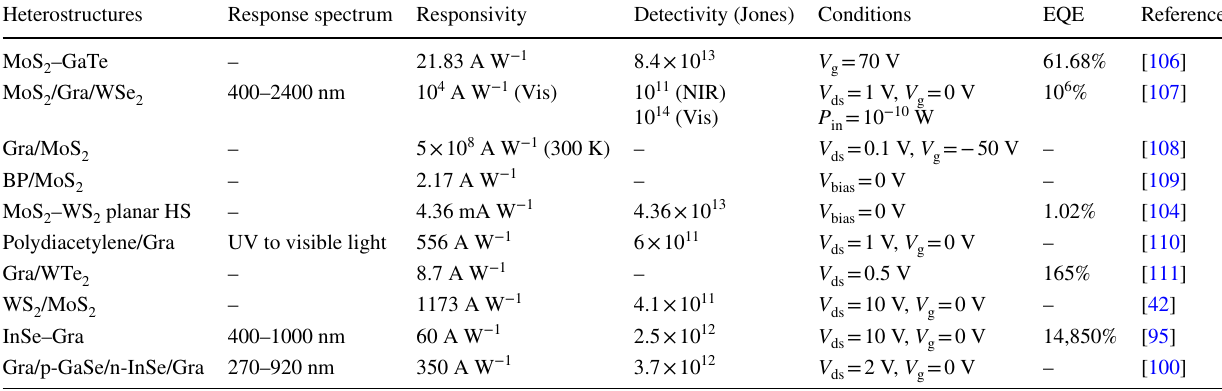
Table 3 The performances of 2D‑heterostructure‑based photodetectors Heterostructures Response spectrum